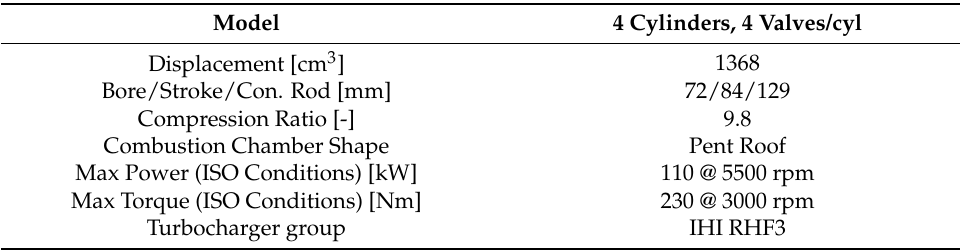
Table 2. Engine main